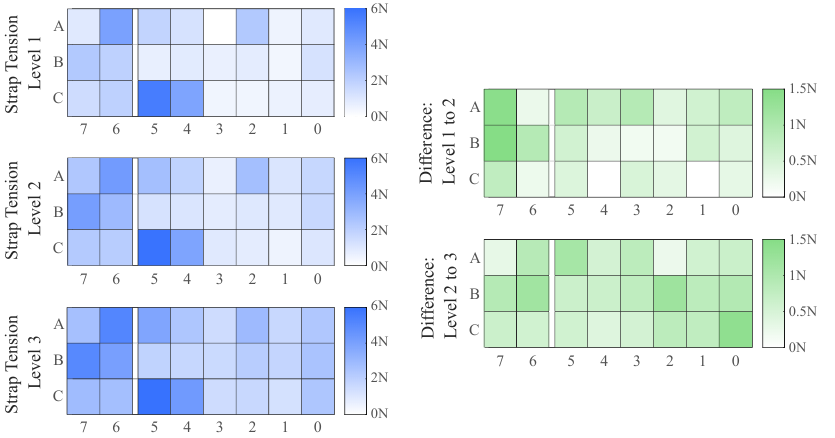
Figure 10. Heatmaps show distributed interface forces in Newtons across rows (vertical axis) and columns (horizontal axis). Note that columns 6 and 7 are on the bicep plate which is separate from the main body of the cuff. (Left) Distributed interface forces measured from FSR data at three strap tension levels where the third level is the tightest. (Right) Difference in distributed forces from the first level to the second level and from the second level to the third